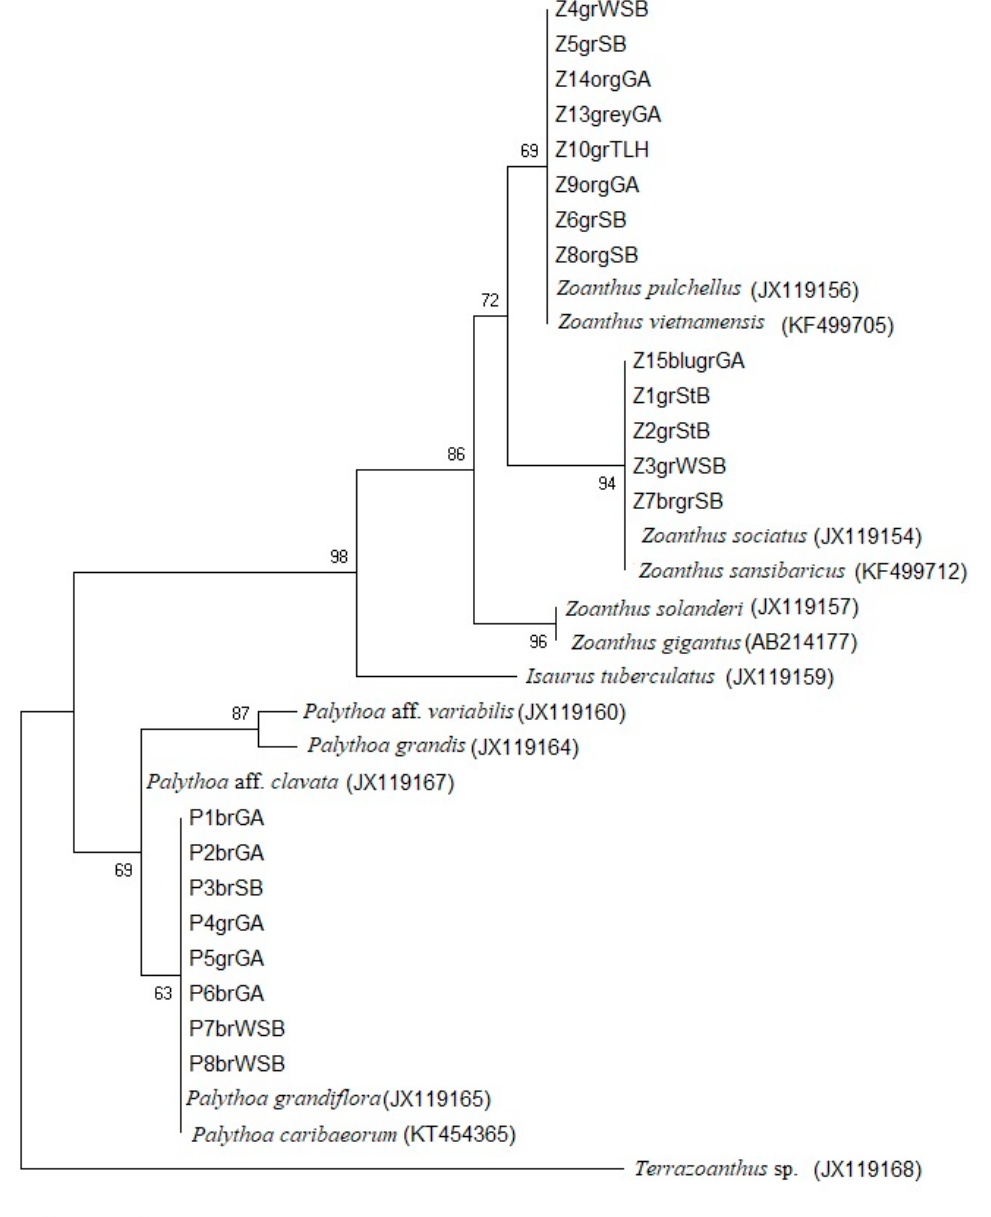
Figure 3. Phylogenetic maximum likelihood tree generated from the mitochondrial COI sequence alignment. GenBank accession numbers from other studies of species shown in parentheses. Numbers above branches represent maximum likelihood probabilities.